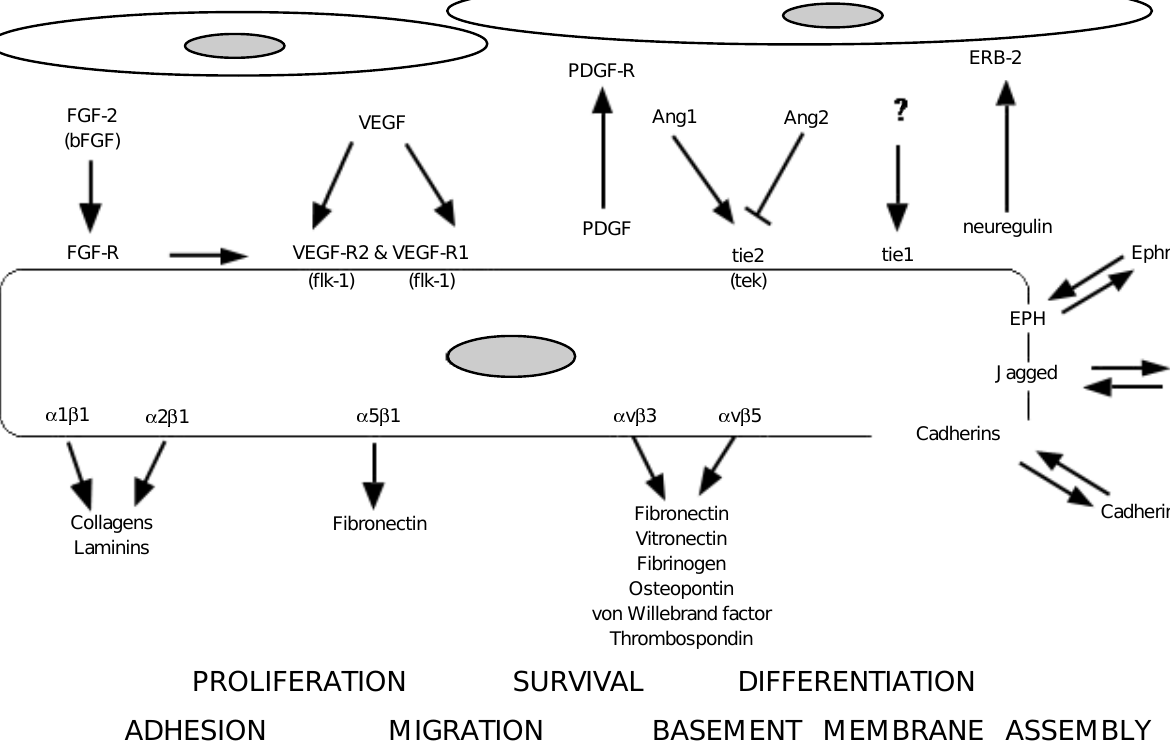
Figure 2 - Interplay of growth factor-receptor signals and cell adhesion receptors. The figure depicts an endothelial cell in the center, expressing various integrins (whose major ligands are noted), which are implicated in one or more aspects of vasculogenesis or angiogenesis (see text) and receptors for basic fibroblast growth factor (FGF-2), vascular endothelial growth factor (VEGF), and angiopoietins. The latter are produced by various cells in the vicinity of developing vessels and those cells in turn receive stimulation by factors secreted by the endothelial cells (e.g., platelet-derived growth factor (PDGF) and neuregulin) that act on receptors on the accessory cells. The latter cells also express and use integrins (data not shown). Thus, there is a two-way “conversation” between endothelial cells and their neighbors and adhesion events involving either or both. Also shown are interactions involving eph/ephrin family members, the Notch pathway and cadherins (see text). At the bottom are shown various cell biological events which must be appropriately controlled to yield vessels of different types. The challenge is to define the interplay among the various receptors and ligands and the contributions made by each to the cell biology of vasculogenesis and